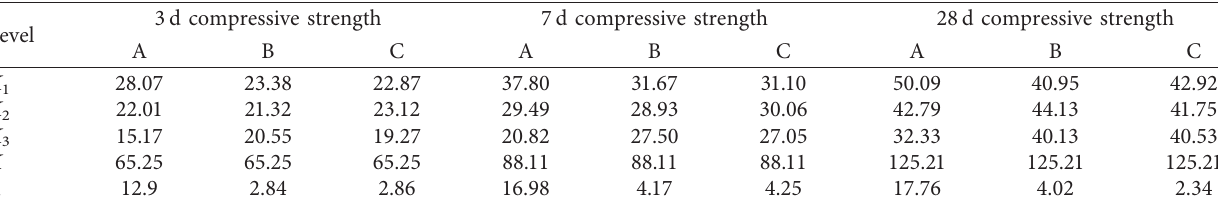
Figure 1: Results of the mechanical properties tests in the orthogonal experiments: compressive strengths at (a) 3d, (b) 7 d, and (c) 28d; (d) flexural strength at 28d. Table 5: Range analysis based on the compressive